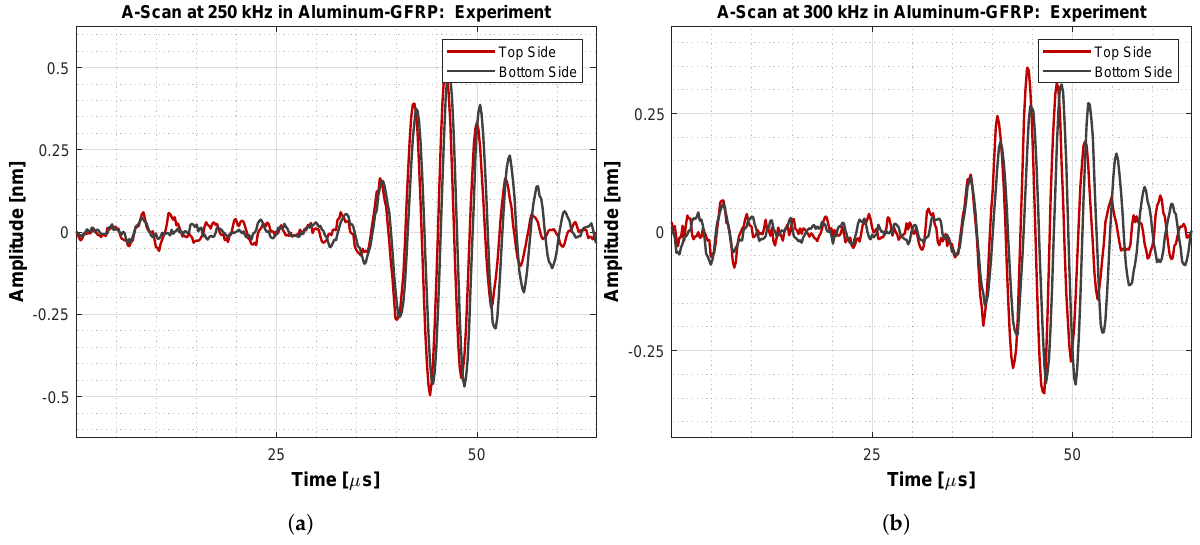
Figure A4. The captured time signals of the aluminum-GFRP plate at all three excitation frequencies showing good congruence between the top surface and bottom surface. ( a ) Time signals of the aluminum-GFRP plate at 250kHz. ( b ) Time signals of the aluminum-GFRP plate at 300kHz.